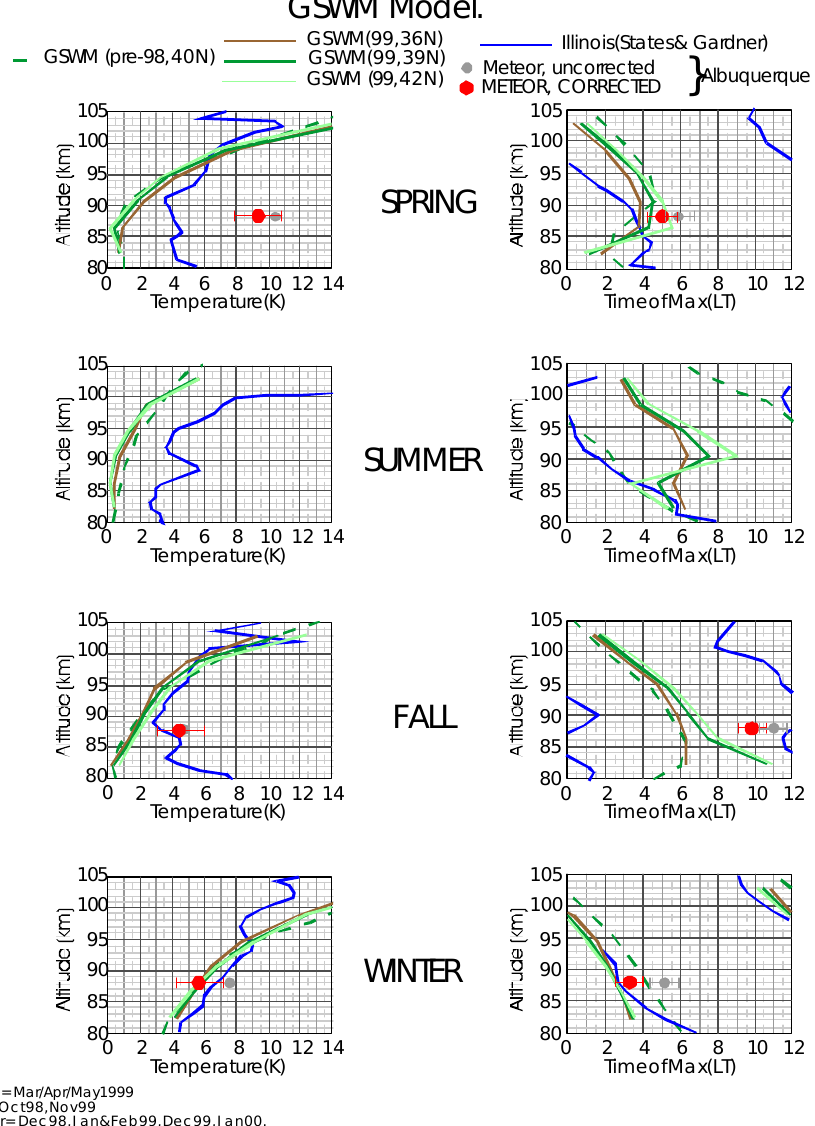
Fig. 5. As for Fig. 4, but for the semidiurnal temperature tide at